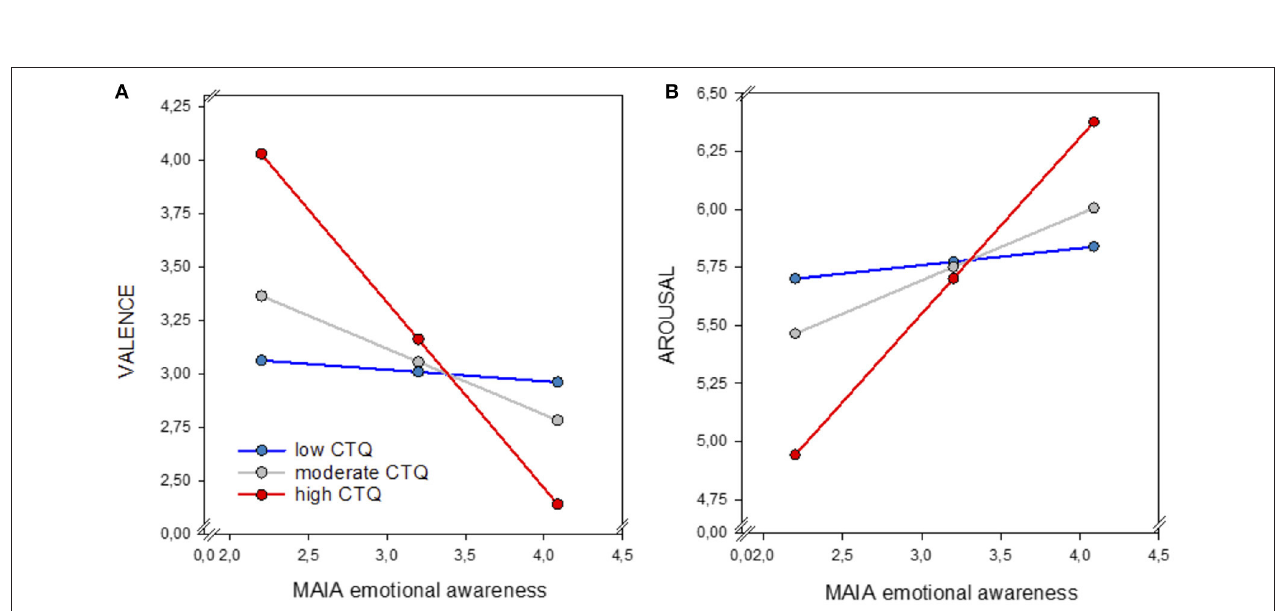
FIGURE 5 | Moderation effect of childhood traumatization (CTQ) on the link between IS emotional awareness (MAIA) and perceived valence (1 = very unpleasant, 8 = very pleasant) (A) and arousal (1 = low arousal, 8 = high arousal) (B) of negative stimuli. Participants reporting higher CTQ scores (red line) and high IS emotional awareness reported higher negative valence and arousal compared to individuals exhibiting high IS emotional awareness but moderate (gray line) or low (blue line) traumatization. IS, interoceptive sensibility; CTQ, childhood trauma questionnaire.